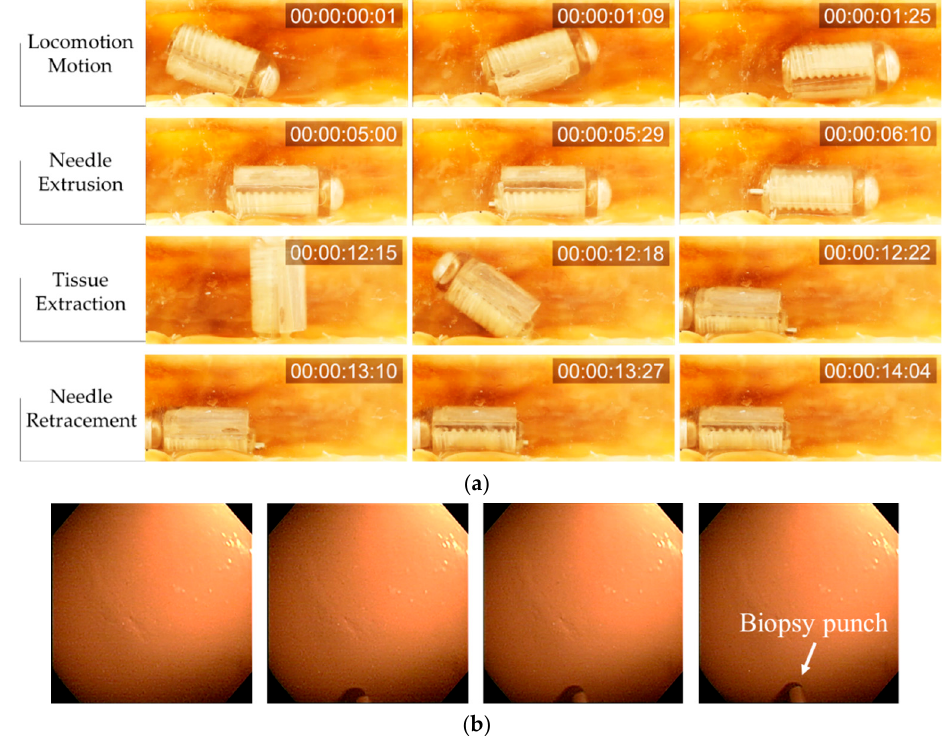
Figure 9. ( a ) Ex-vivo locomotion and biopsy experiment in chronological sequence. A real-time watch was added, which shows the time in the format hour:min:sec:frame. ( b ) Images obtained using the camera of the CE as the biopsy punch was extruded.